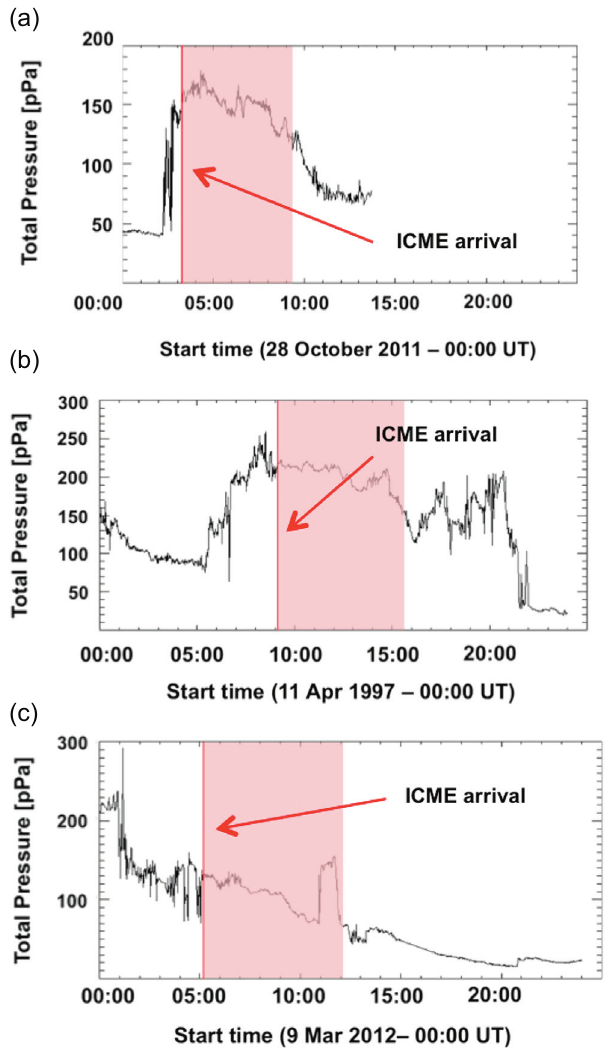
Fig. 6. Examples of total pressure profiles during ICME passages. The red arrow marks the ICME arrival time based on the criterion of temperature drop compared to the expected temperature at the same solar wind speed. The area with a constant low temperature profile is coloured in red. Interpretation of the total pressure profile from the criterion by Jian et al. (2006): (a) G1, spacecraft encounters the ICME near its nose, (b) G2 and (c) G3, spacecraft encounters the ICME flank.